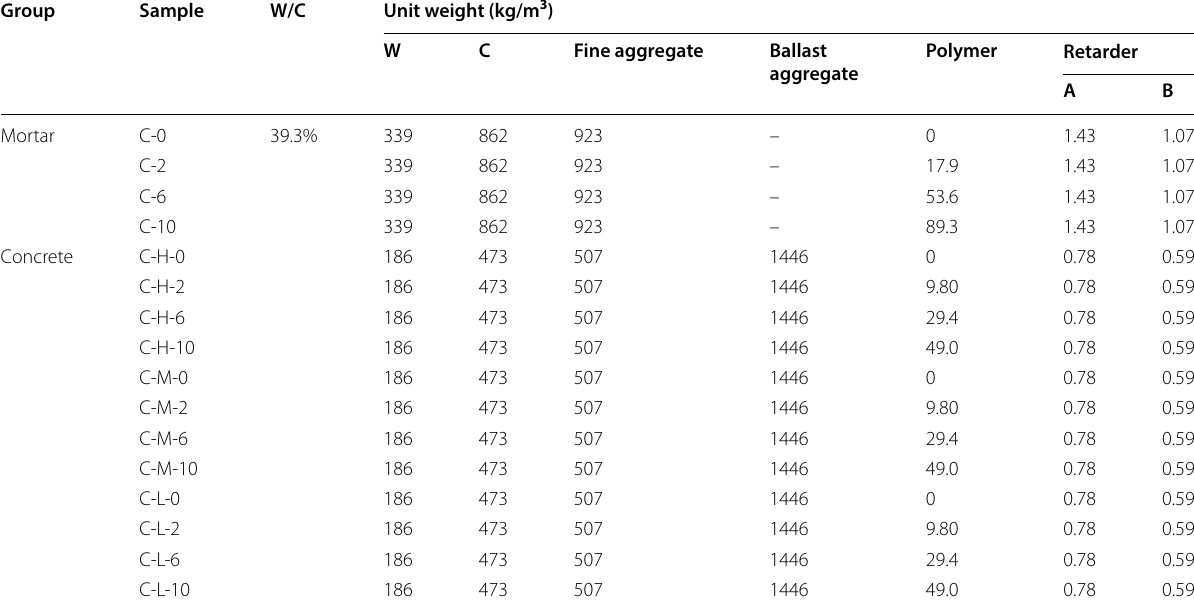
Table 4 Mix proportions of four mortar samples and twelve concrete samples. Group